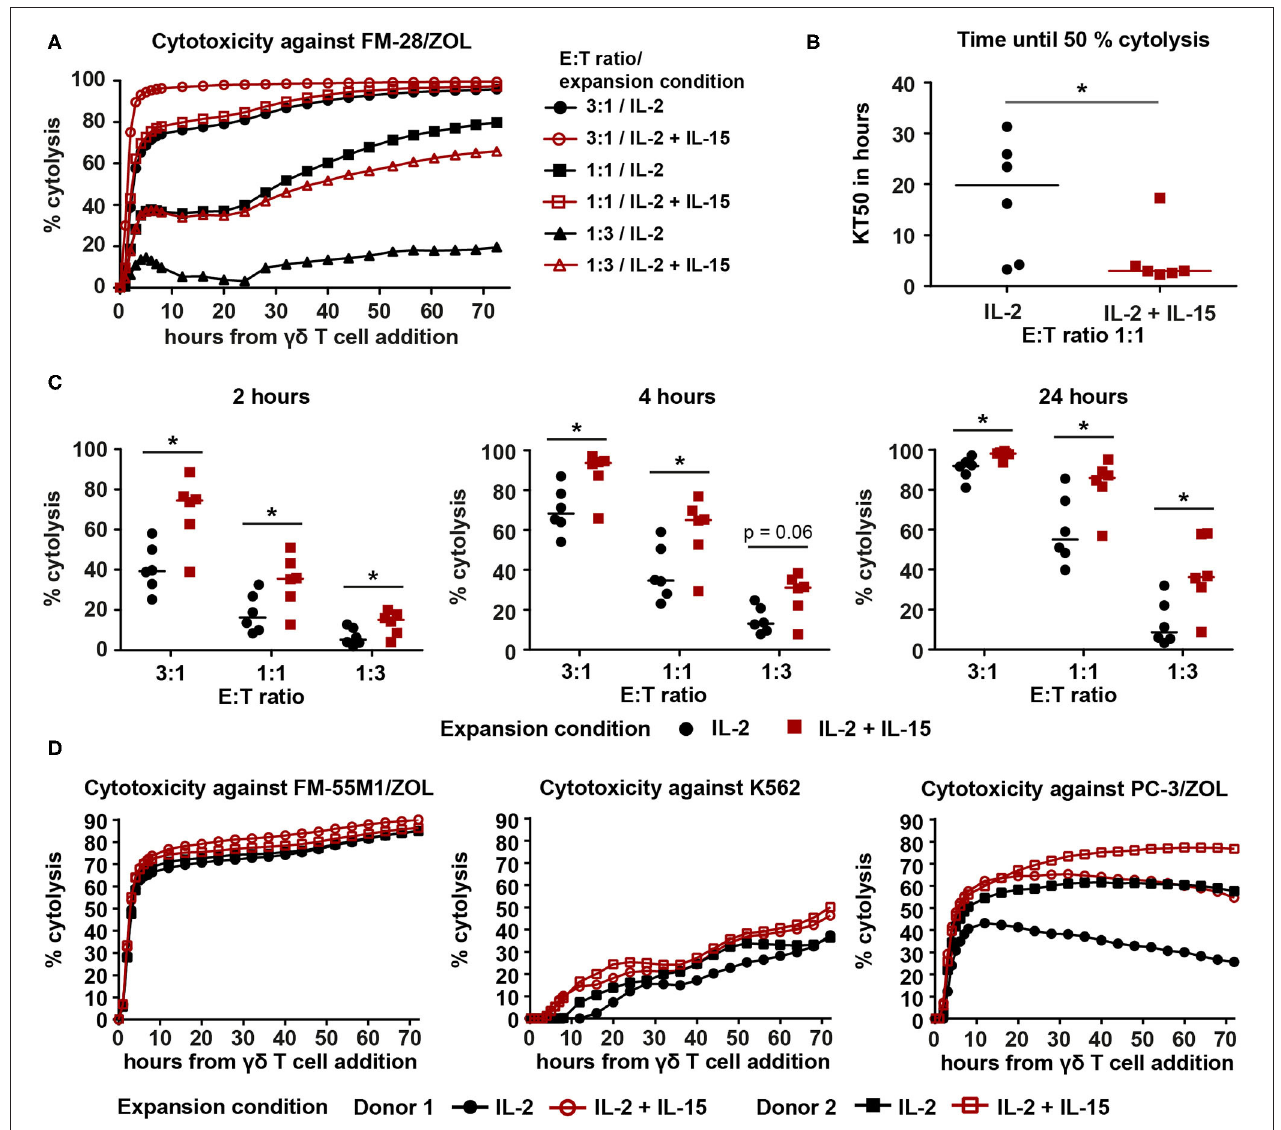
FIGURE 2 | IL-2/IL-15-expanded V γ 9V δ 2T cells show enhanced cytotoxicity against various cancer cell lines in a 72-h xCELLigence real-time cell analysis assay. (A) Representative cytolysis plot, comparing V γ 9V δ 2T cell ability to kill FM-28/ZOL between the two expansion conditions. The experiment was conducted at three different effector–target cell ratios (3:1, 1:1, 1:3). Black symbols belong to IL-2-expanded cultures, whereas red symbols indicate IL-2/IL-15-expanded cultures. Lines represent means of three technical replicates. (B) Time to kill 50% of the target tumor cells (KT50) was compared between both expansion conditions at an effector–target cell ratio of 1:1. Horizontal lines depict the median KT50 of the respective expansion conditions ( n = 6, compiled from two independent experiments, γδ HD7–12). (C) Comparison of percentage of cytolysis at time points 2, 4, and 24h after addition of IL-2-expanded vs. IL-2/IL-15-expanded V γ 9V δ 2T cells. Percentage of cytolysis is shown for different effector–target cell ratios. Horizontal lines indicate median cytolysis ( n = 6, compiled from two independent experiments, γδ HD7–12). (D) Cytolysis plots comparing V γ 9V δ 2T cell ability to kill FM-55M1/ZOL (left plot), K562 (middle plot), and PC-3/ZOL (right plot) between expansion conditions. Cytotoxicity was assessed at an effector–target cell ratio of 1:1 for FM-55M1/ZOL and PC-3/ZOL and at a ratio of 3:1 for K562. Black, filled symbols indicate IL-2-expanded cultures, whereas matching red, empty symbols indicate the associated IL-2/IL-15-expanded cultures ( n = 3 with n = 2 per cell line, compiled from two independent experiments; γδ HD9,10,12). % cytolysis and KT50 were calculated using the xCELLigence RTCA Software Pro (ACEA Biosciences). Statistical significance was determined with the Wilcoxon matched-pairs signed-rank test. * p < 0.05. FM-28, FM-55M1 = melanoma cell lines. K562 = chronic myelogenous leukemia cell line. PC-3 = prostate cancer cell line. /ZOL = 24-h-pre-stimulation with ZOL.